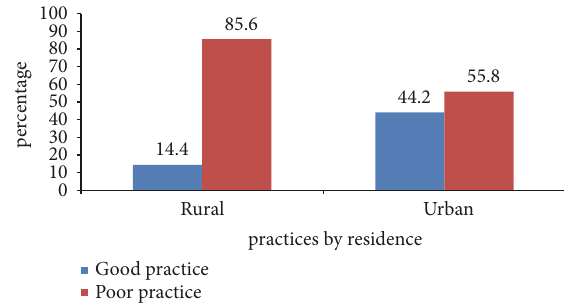
Figure 2: Magnitude of home management practice of diarrhea among caregivers of under-five children in urban and rural resident of Doba woreda,